Question: Briefly state, in one sentence, what is plotted here.
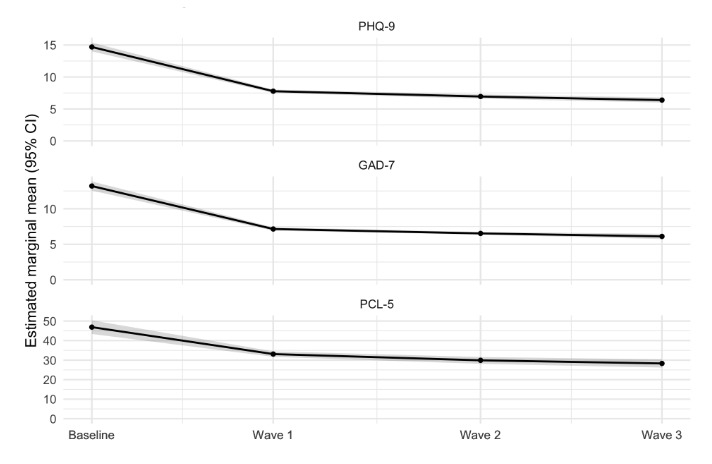
Answer: Estimated marginal means (95% CI) for Generalized Anxiety Disorder-7 Scale (GAD-7), Posttraumatic Stress Disorder Checklist for Diagnostic and Statistical Manual of Mental Disorders (Fifth Edition; PCL-5), and Patient Health Questionnaire-9 (PHQ-9) symptom trajectories over time (wave 1=after 2 sessions; wave 2=after 4 sessions; wave 3=after 6 sessions).